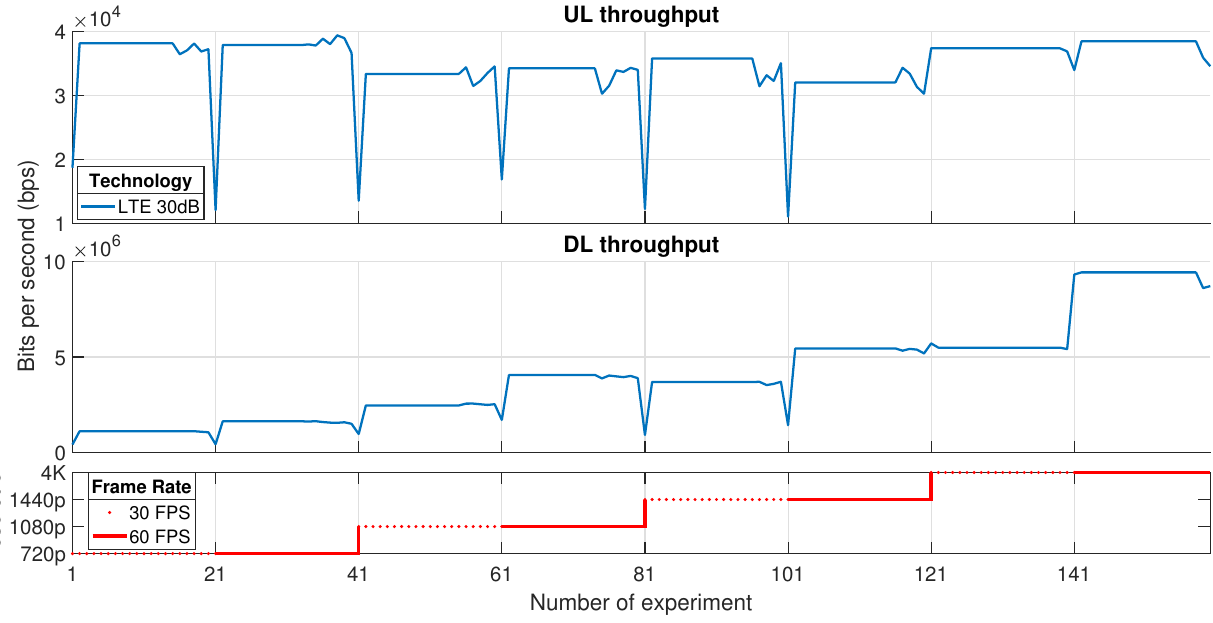
Figure 12. Uplink (UL) and Downlink (DL) bitrate in Long Term Evolution (LTE) testbed.